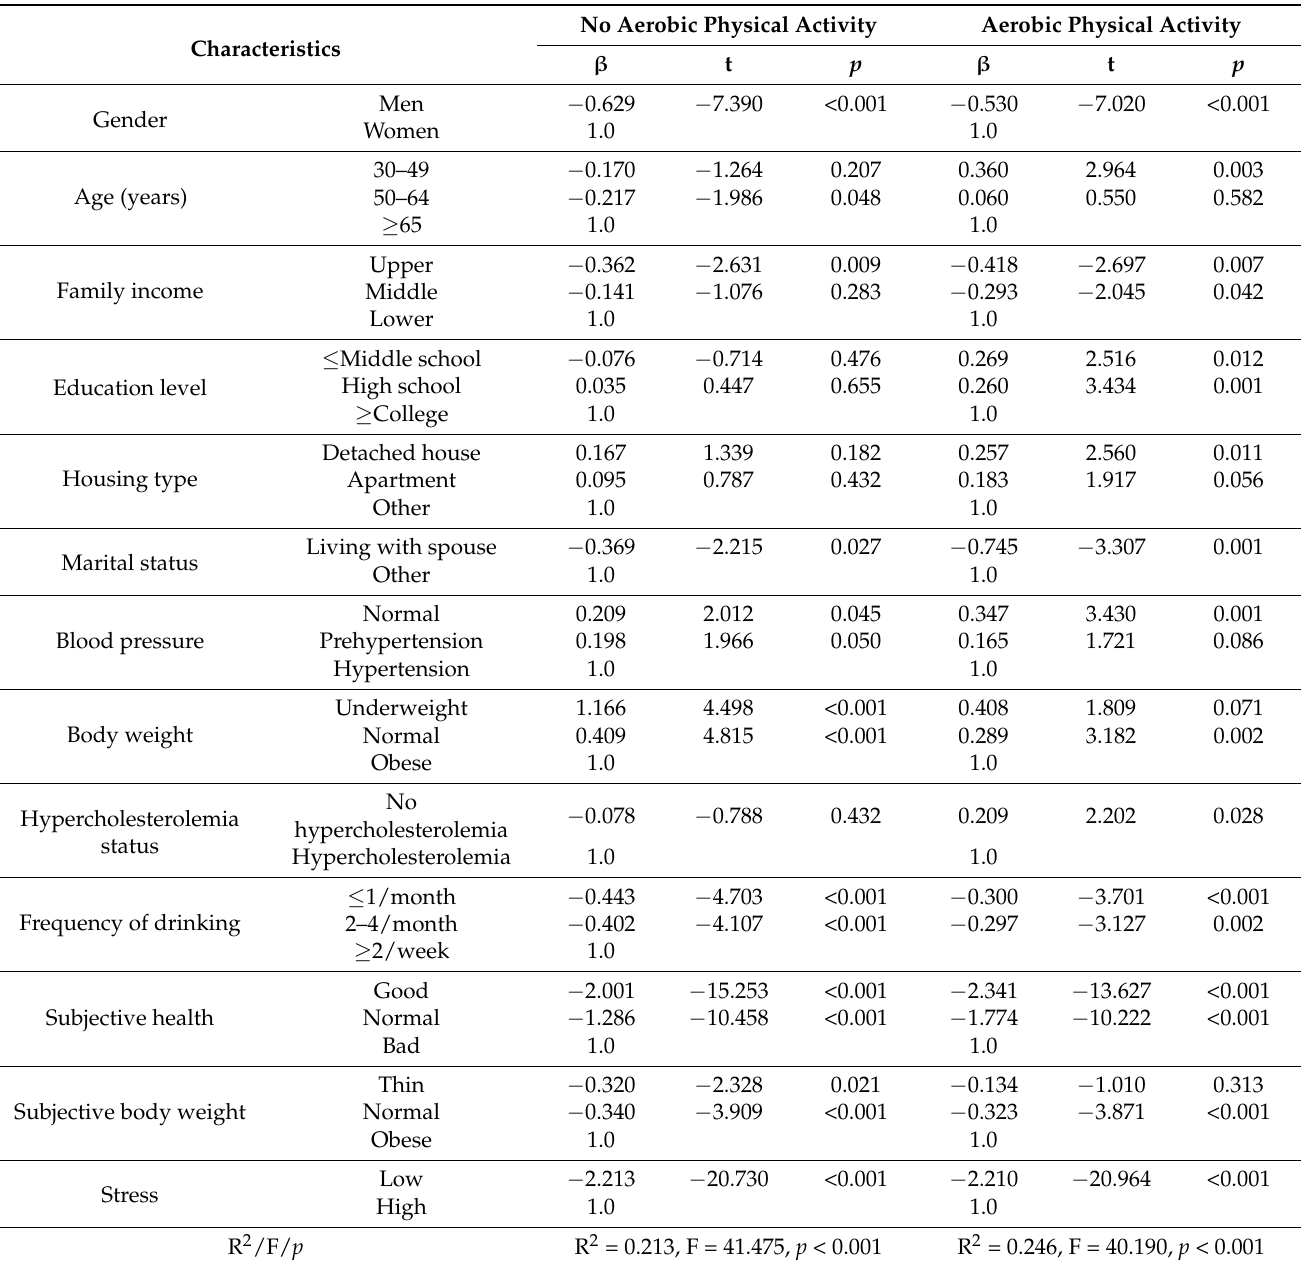
Table 3. Factors associated with depression ( n =